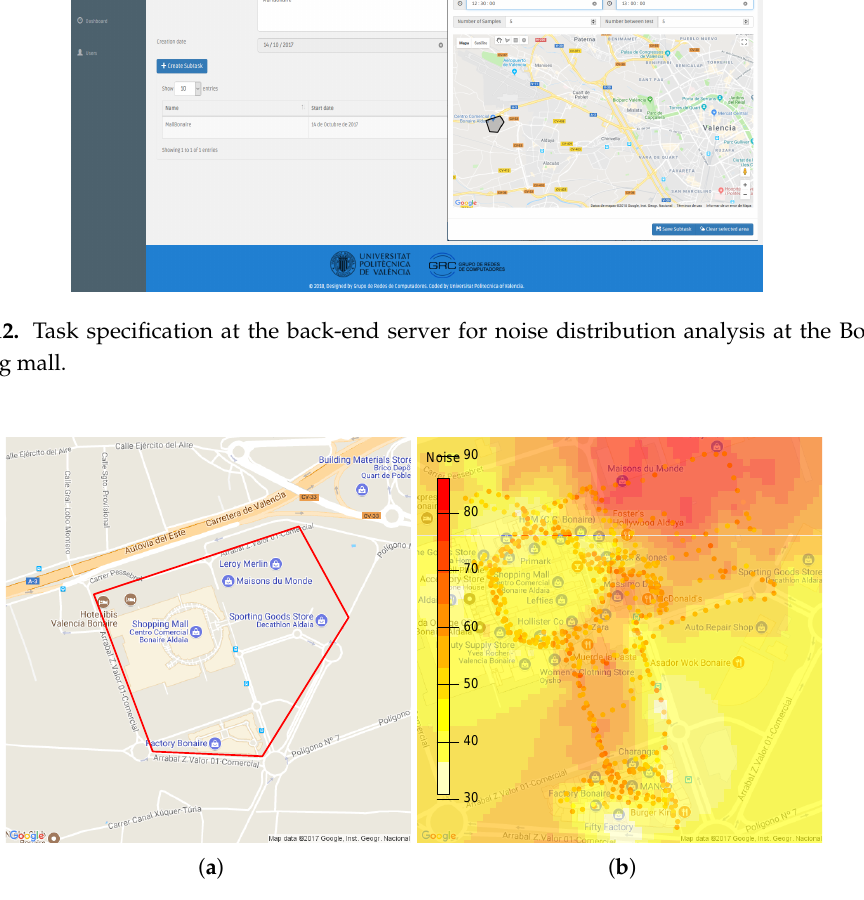
Figure 13. Analysis of the environmental noise in a shopping mall. ( a ) Task specification at the back-end server; ( b ) Noise distribution of the shopping mall